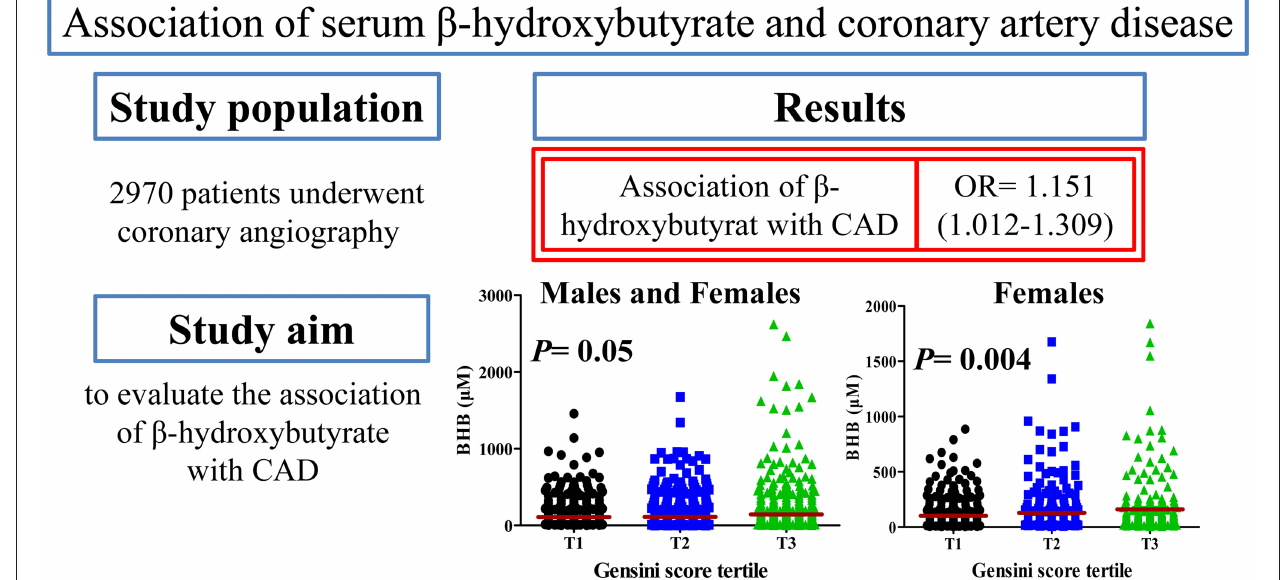
FIGURE 4 | Overview of this study. CAD, coronary artery disease; OR, odds ratio.